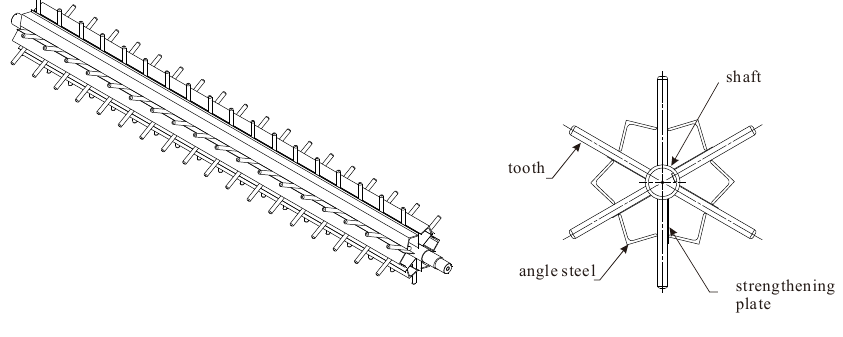
Figure 4. Model of a feeding rolle r.